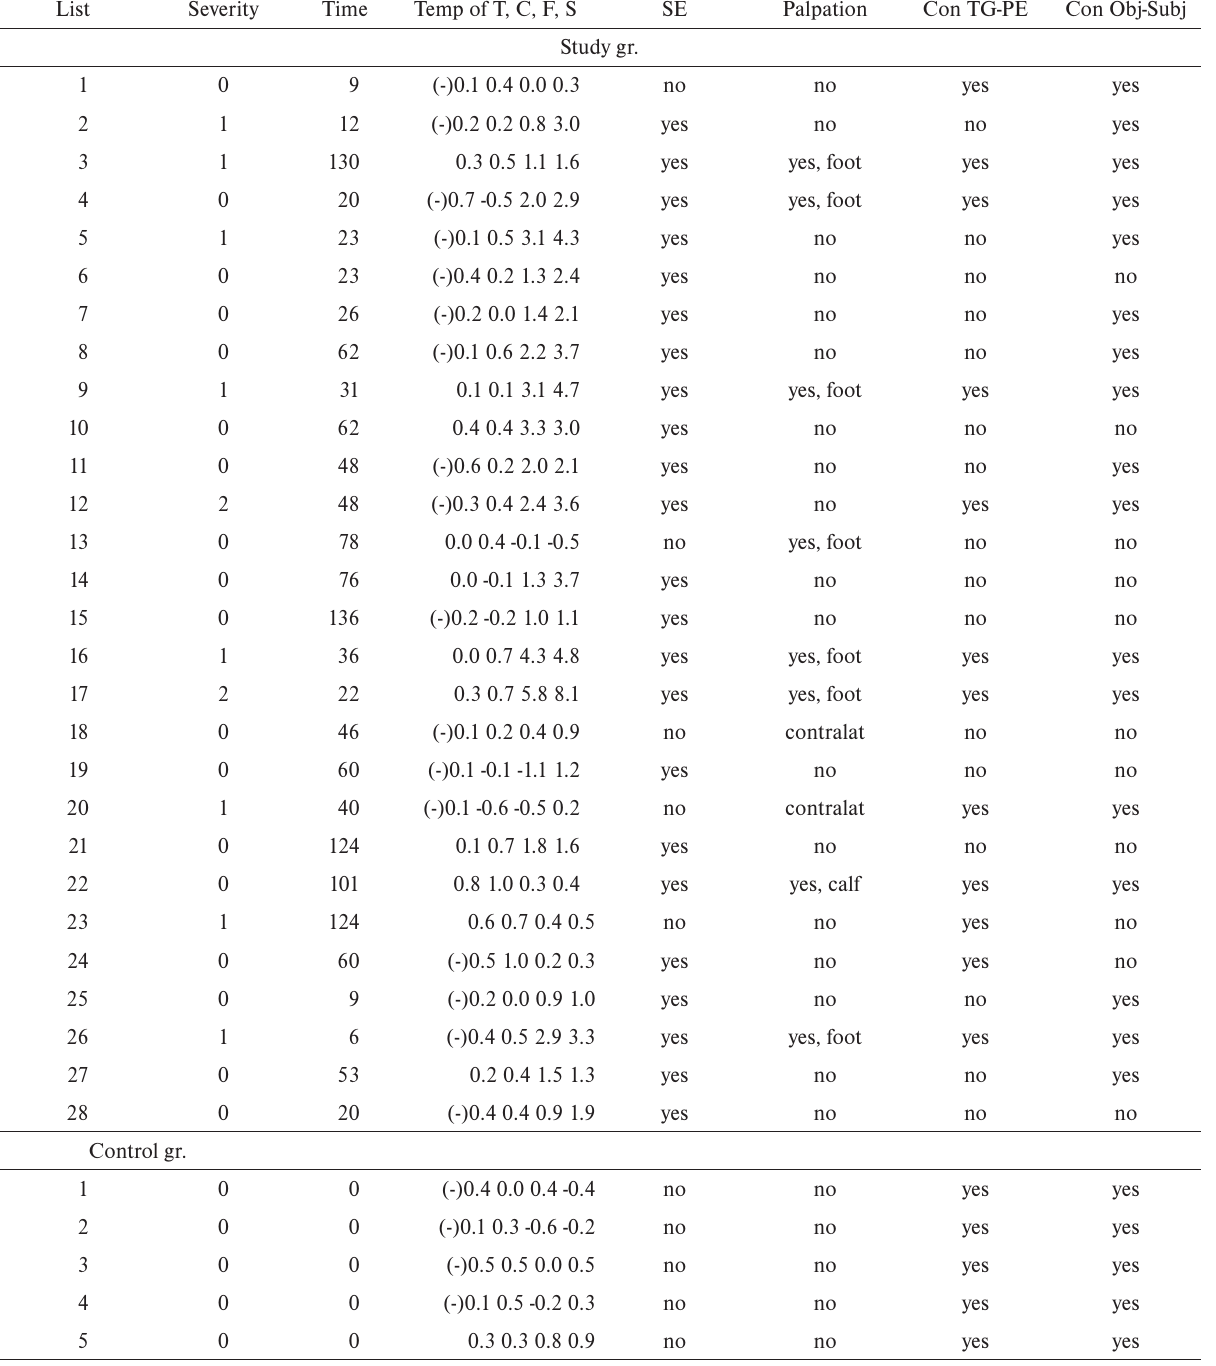
Table 3. Results of clinical examinations and